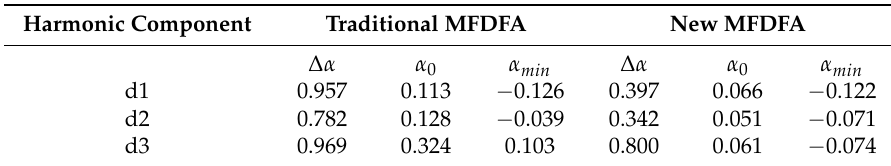
Table 2. ∆ α , α 0 and α min values of the harmonic component computed analytically through traditional MFDFA and new MFDFA.